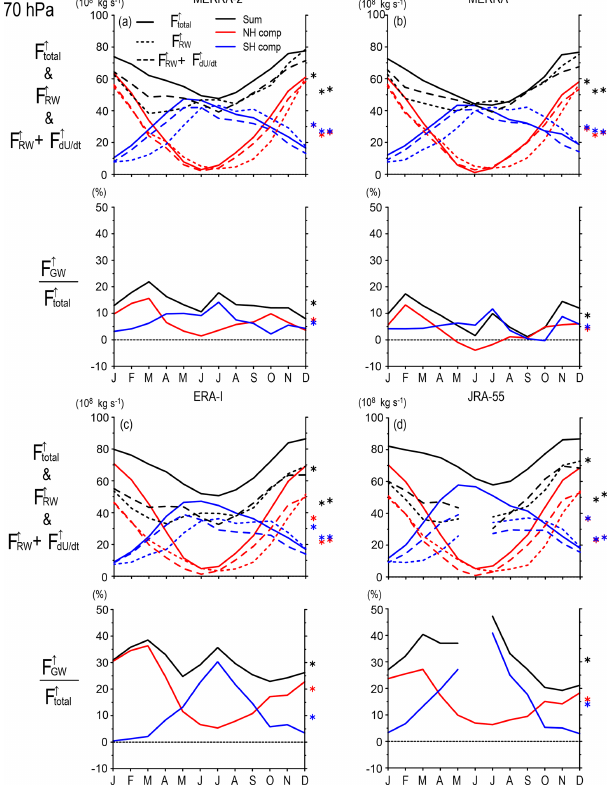
Figure 10. Upward mass flux at 70hPa as a function of the month for (a) MERRA-2, (b) MERRA, (c) ERA-Interim, and (d) JRA- 55. (a, b) Black solid curves show the net upward mass flux, and red (blue) solid curves show contributions of the NH and SH. Solid curves show the total mass flux. Dashed curves show potential con- tributions of RWs plus the tendency of the zonal mean zonal wind. Asterisks on the right show the annual mean of total mass flux, po- tential RW contribution, potential RW contribution plus contribu- tion of the zonal mean zonal wind tendency from the left. (c, d) Per- centage of the potential contribution of GWs to the total mass flux. The asterisks on the right show their annual mean. Contributions by each wave and zonal wind tendency could not be calculated in JJ in the SH for JRA-55 because the turn-around latitude was lower than 20 ◦